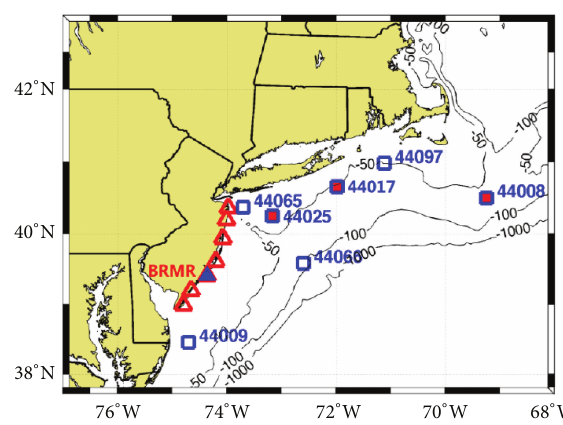
Figure 2: Geographic map of the buoys and the SeaSonde site involved (reproduced from